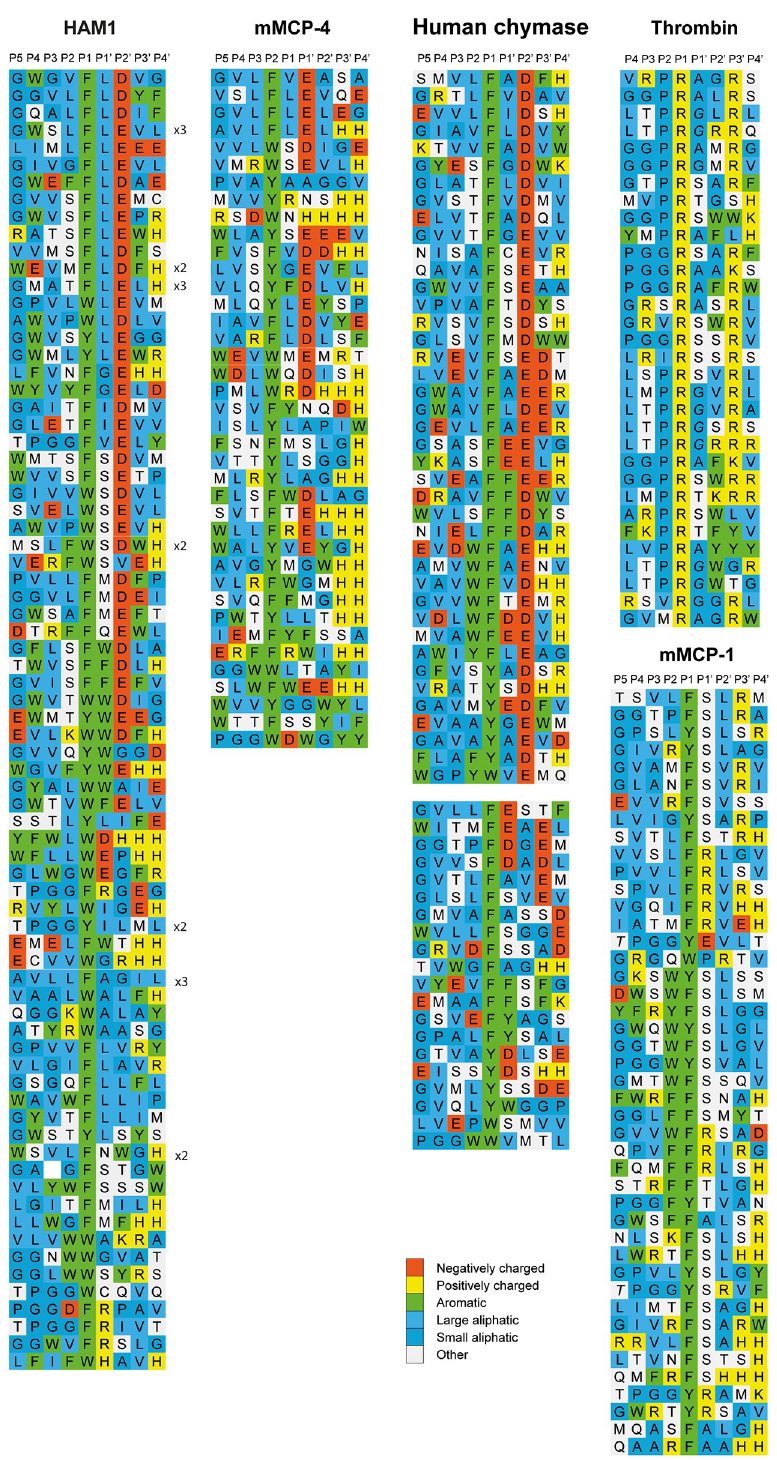
Fig 4. Phage displayed nonamers susceptible to cleavage by HAM1 after five biopannings. After the last selection step, phages released by proteolytic cleavage of the three proteases were isolated and the sequences encoding the nonamers were determined. The general sequence of the T7 phage capsid proteins are PGG(X) 9 HHHHHH, where (X) 9 indicates the randomized nonamers. The protein sequences were aligned into a P5-P4´ consensus, where cleavage occurs between positions P1 and P1´. If the sequence was found more than once this is indicated by the